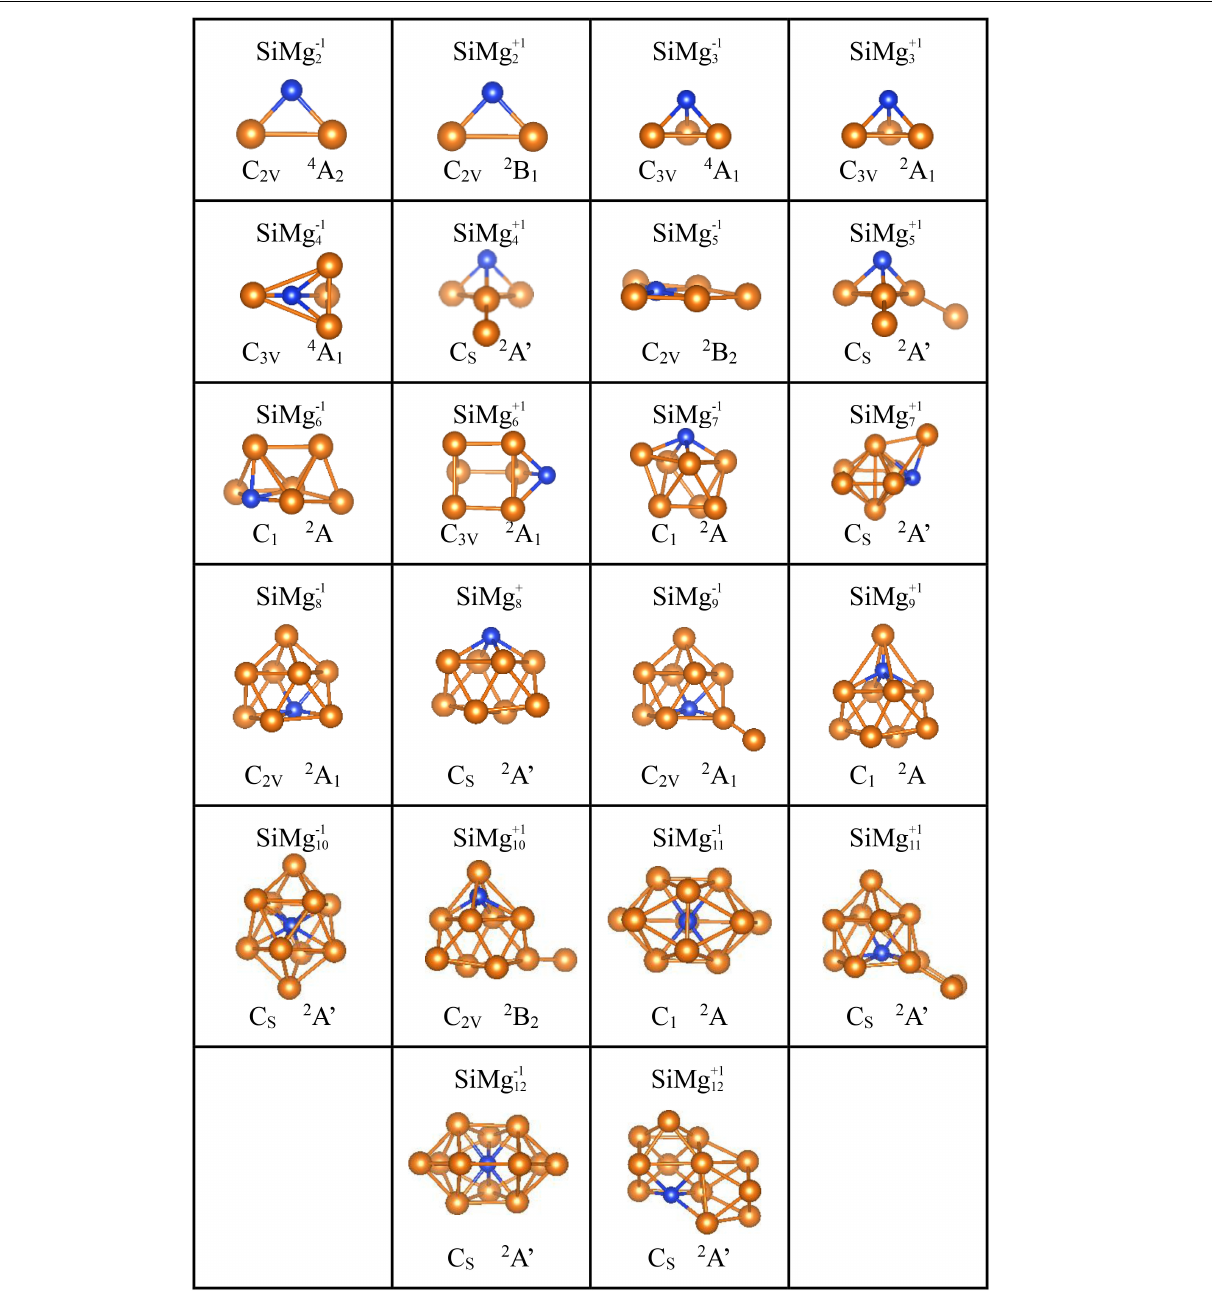
structure, and the geometric structures of SiMg 7 − 1 and SiMg 8 + 1 in Figure 2 confirms this conclusion. NCP shows that the charges are transferred from Mg atoms to Si atoms in SiMg n ± 1 ( n = 2 − 12) clusters. Si atom acts as charge receiver while the Mg atoms are charge donors is probably originated from the fact that electronegativity value of Si (1.90) is greater than that of Mg atom